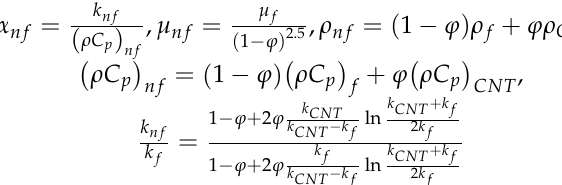
Table 1. Thermophysical properties of CNTs (Khan et al.